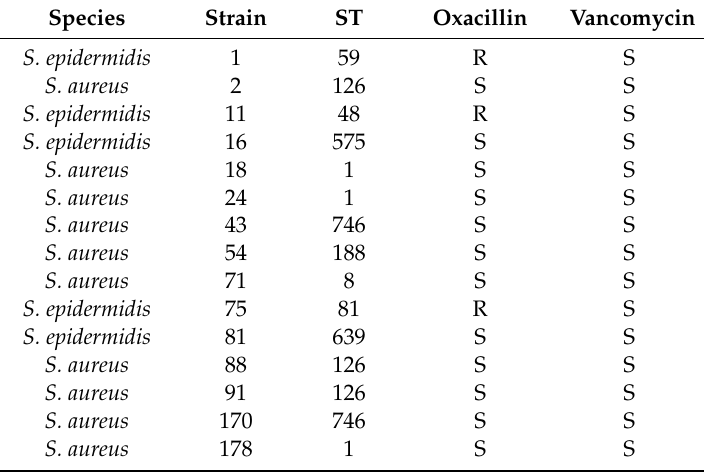
Table 6. Susceptibility profile of the isolates according to sequence type